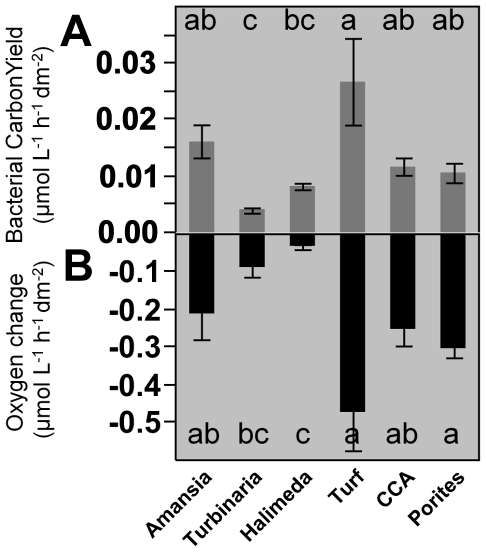
Rates of A.) bacterial carbon yield and B.) DO consumption on exudates over ∼48 hour dilution culture incubations normalized to surface area of previously incubated primary producers.Bars are means with standard error whiskers; treatments with the same letter are not significantly different at α = 0.05.